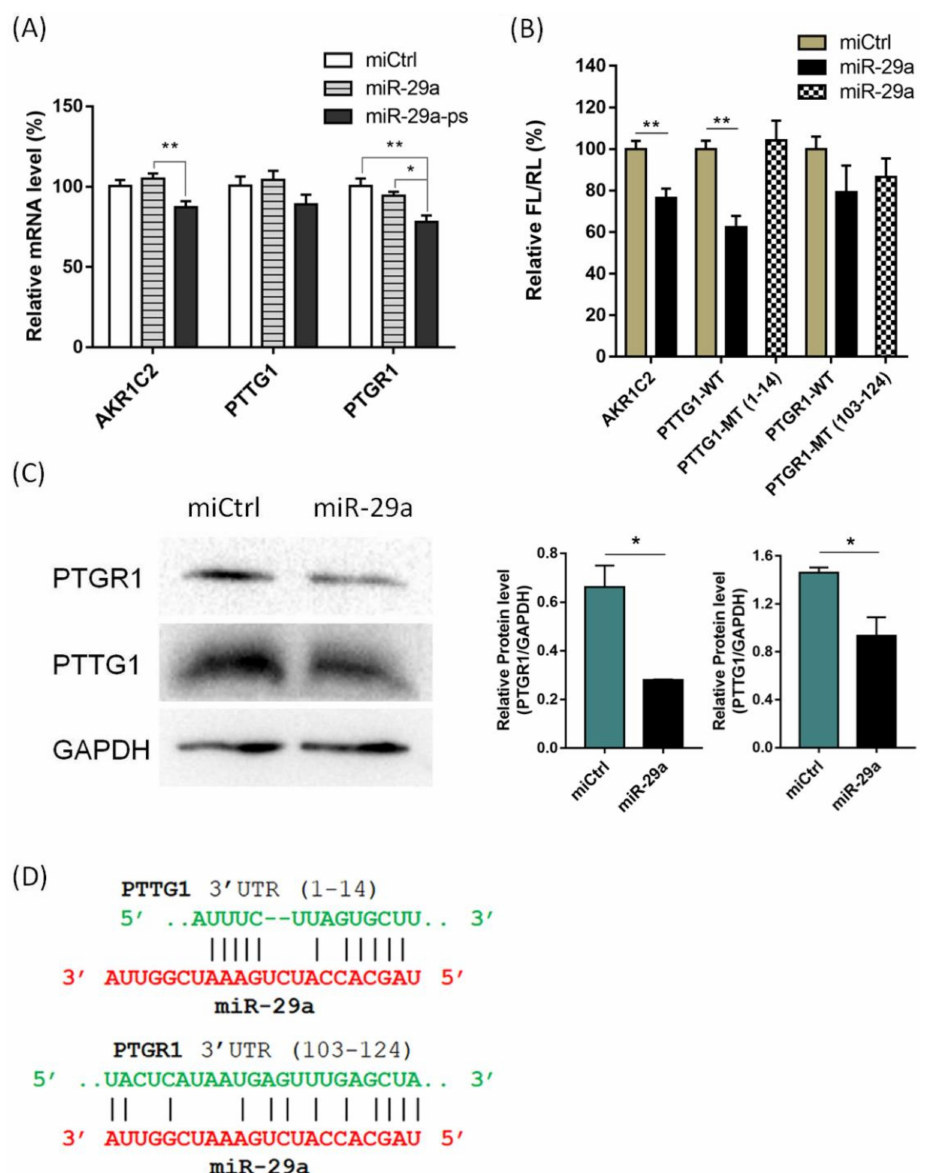
Figure 4. Validation of potential targets of miR-29a. ( A ) qPCR analysis of 3 potential targets that were specifically downregulated only by miR-29-ps; ( B ) Dual luciferase assay showed that AKR1C2 , PTTG1 and PTGR1 have direct binding site of miR-29a in the 3 (cid:48) UTR region of corresponding mRNA. WT represents wildtype 3 (cid:48) UTR-containing reporters and MT represents mutant type 3 (cid:48) UTR-containing reporters; ( C ) Western blotting analysis showed that PTGR1 and PTTG1 protein levels were significantly decreased in the cells transfected with miR-29a; and, ( D ) Potential binding site for miR-29a in the 3 (cid:48) UTR of PTTG1 and PTGR1 mRNA (computed by FIMO [41]). All error bars represent mean ± SD of three independent experiments, and samples with p < 0.05 (one-way ANOVA) are marked with asterisks (*, p < 0.05; **, p <